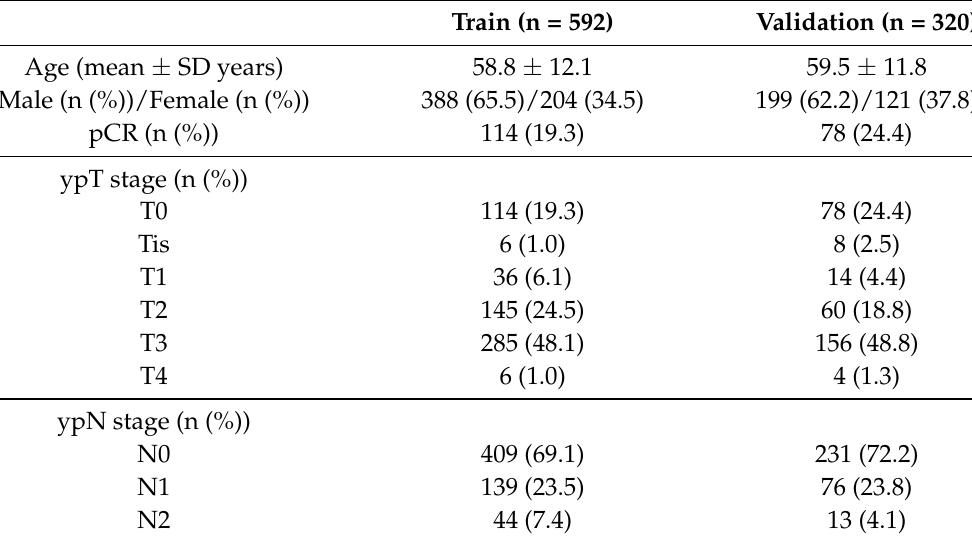
Table 1. Disease stages of rectal cancer patients (total =